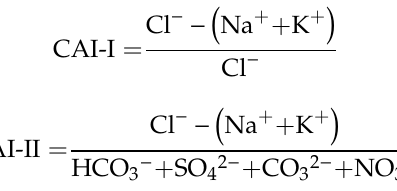
Figure 10. Gibbs diagrams of ( a ) Na + /(Na + +Ca 2+ ) and ( b ) Cl − /(Cl − +HCO 3 − ).